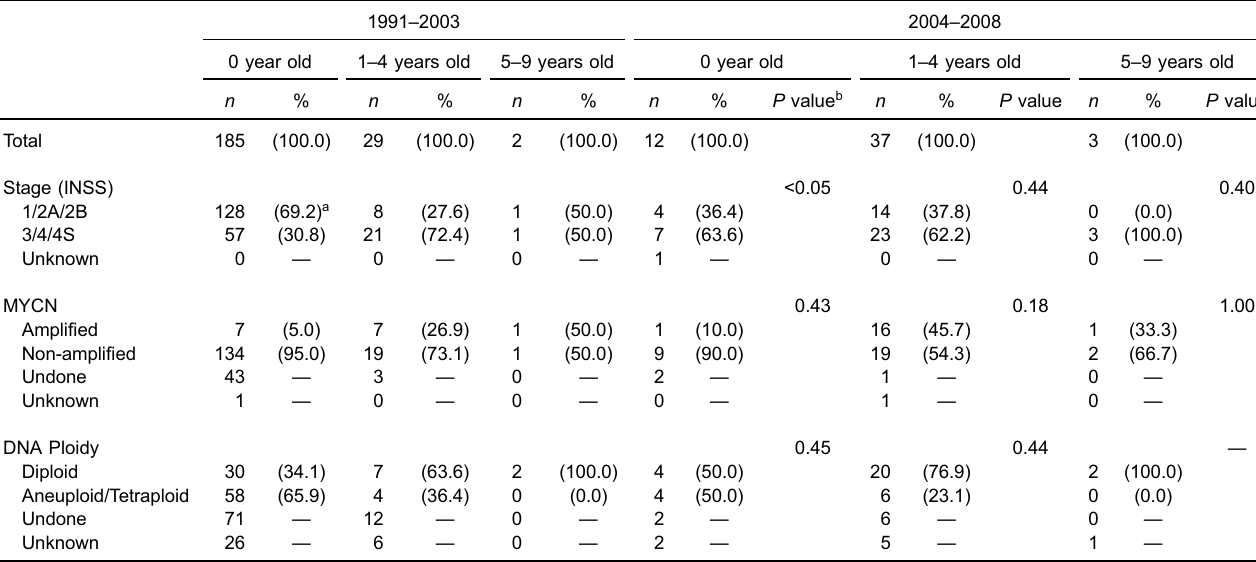
Table 4. Prognostic factors for neuroblastoma